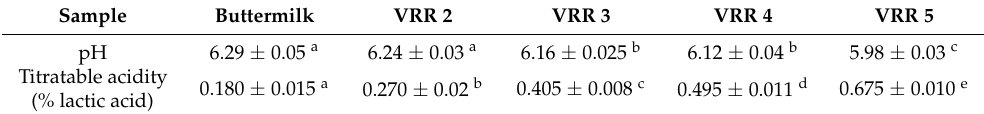
Table 1. Titratable and active (pH) acidity of retentates at different volume reduction ratios. Sample